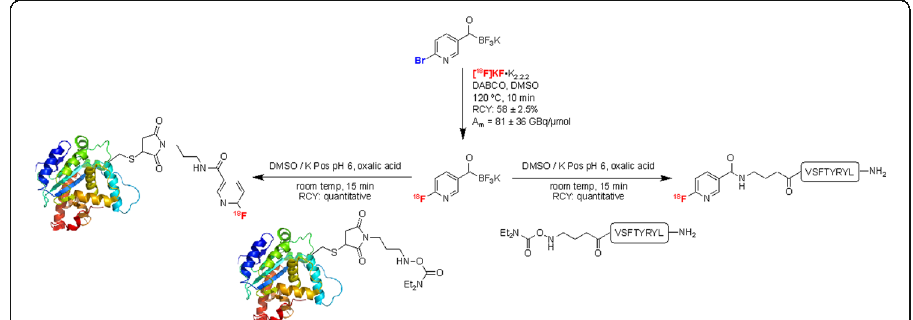
Fig. 8 Radiolabeling of peptides and proteins using 6-[ 18 F]fluoropyridyl acyltrifluoroborate ([ 18 F]FPAT).